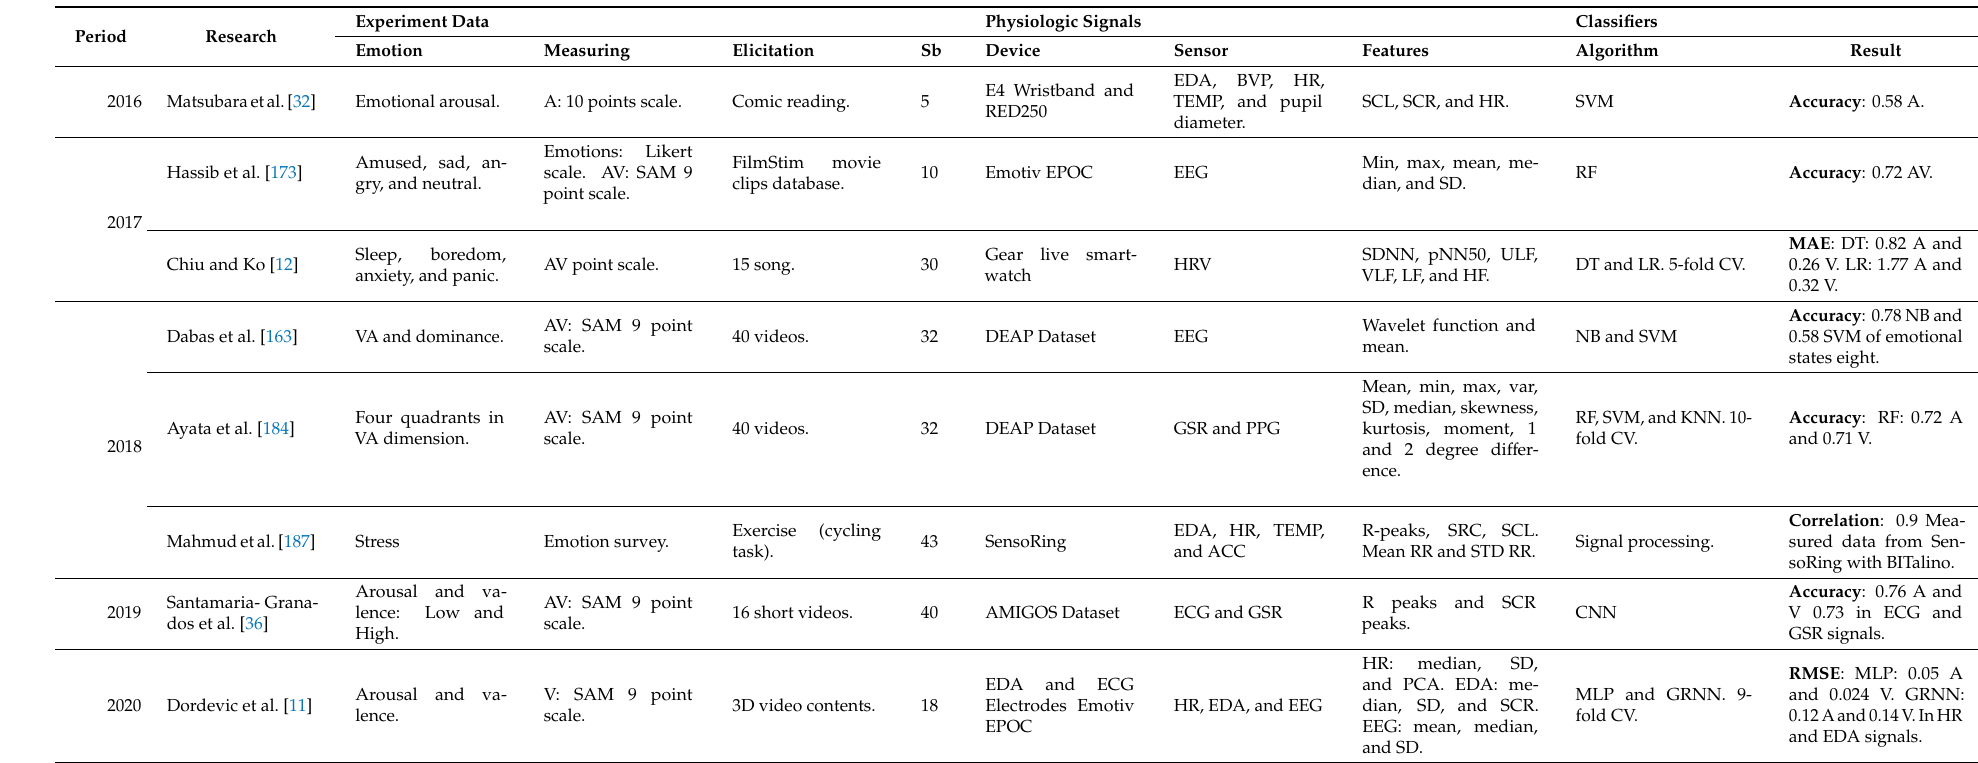
Table 4. Emotion recognition studies are based on data from wearable